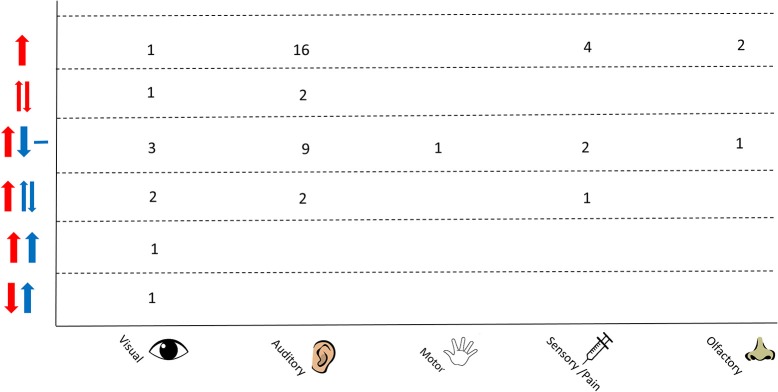
Chart showing observed responses separated by stimulus type. Number of studies showing observed response is shown. Directions of arrow indicate whether an increase, decrease, varied response or no change was seen in the NIRS parameter. Δ[HbO2] is shown in red and Δ[HHb] in blue.